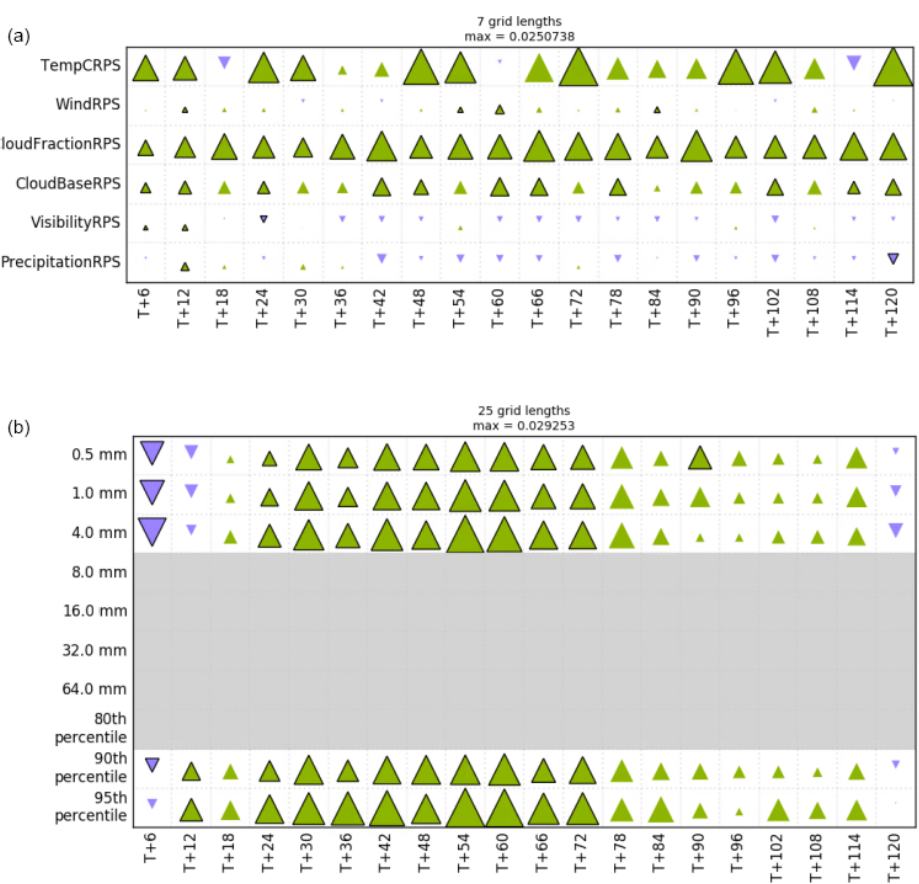
Figure 13. RAL2-T vs. RAL1-T HiRA summary scorecard at 30km (7 grid lengths) spatial scale (a) and FSS summary scorecard at 110km (25 grid lengths) for precipitation (b)